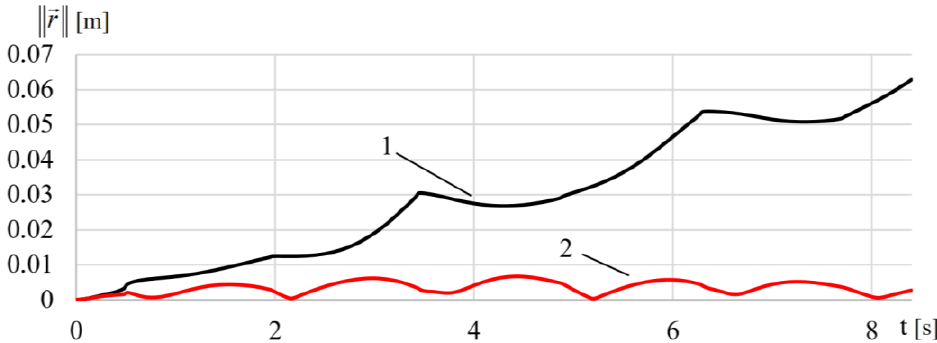
→ (cid:13) (cid:13) r (cid:13) (cid:13) of UUV’s linear displacements.